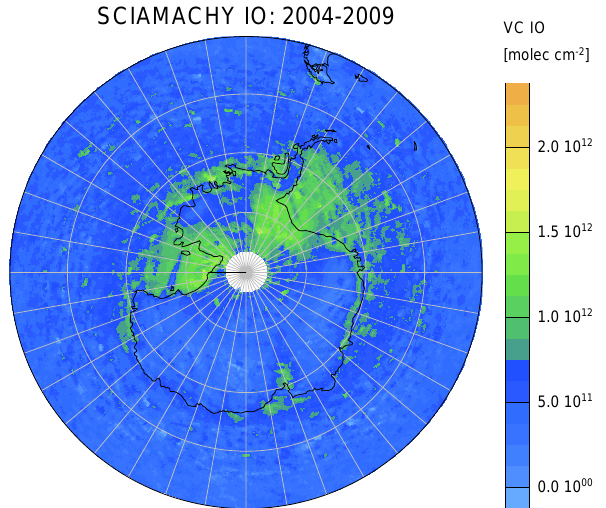
Fig. 1. IO vertical columns above the Antarctic region averaged over the total period of six years, from 2004 to 2009. Different types of areas show enhanced IO amounts – sea ice regions, ice shelves, coast lines, and parts of the continent.